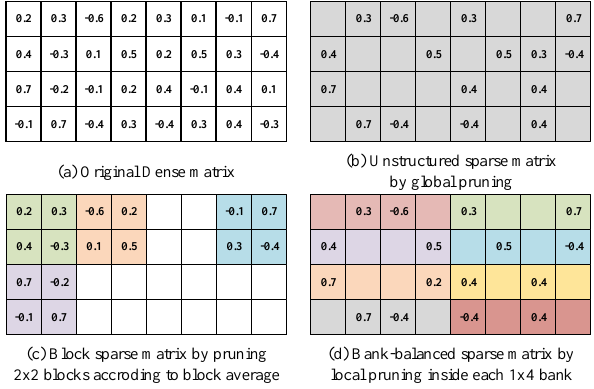
Figure 13. Comparison of unstructured sparsity, block sparsity and bank-balanced sparsity [19]. Unstructured sparsity selects the smallest number (50%) of weights globally; block sparsity divides the entire matrix into 8 banks with a 2 × 2 size and represents each bank with their average weight; and bank-balanced sparsity splits each matrix row into 2 equal banks and fine-grained prunes within every